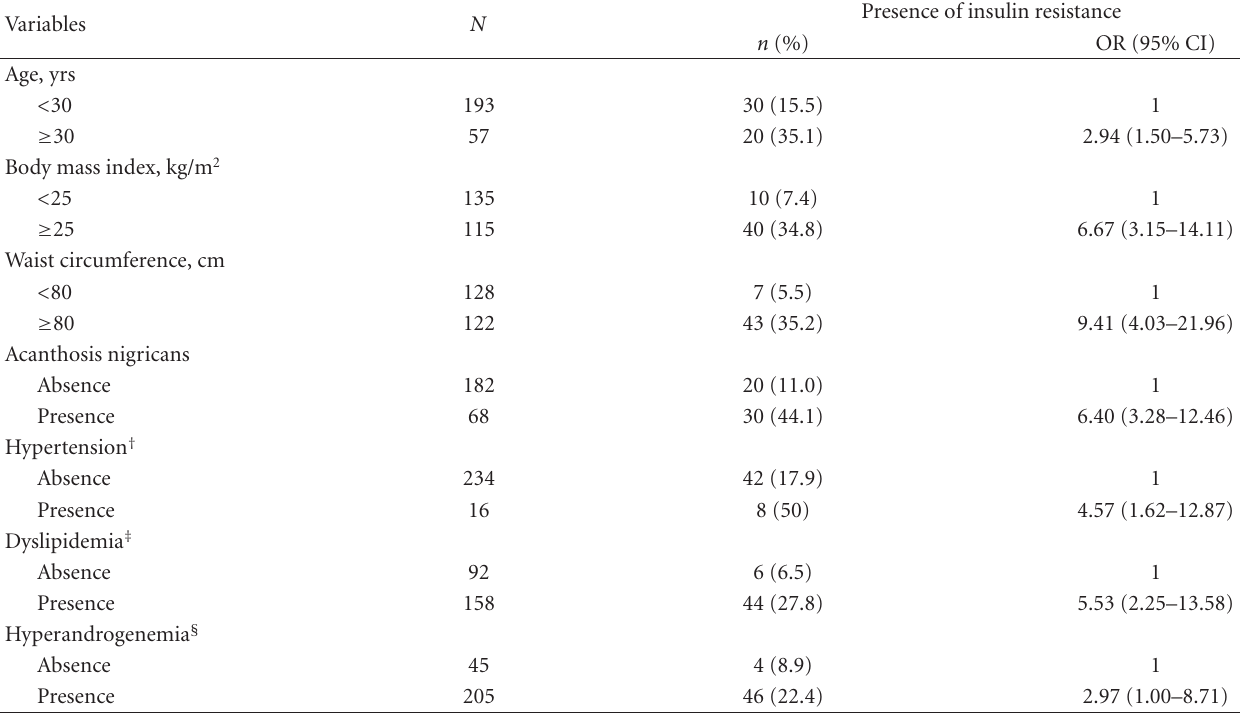
Table 3: Predictors for insulin resistance in 250 Thai women with polycystic ovary syndrome.